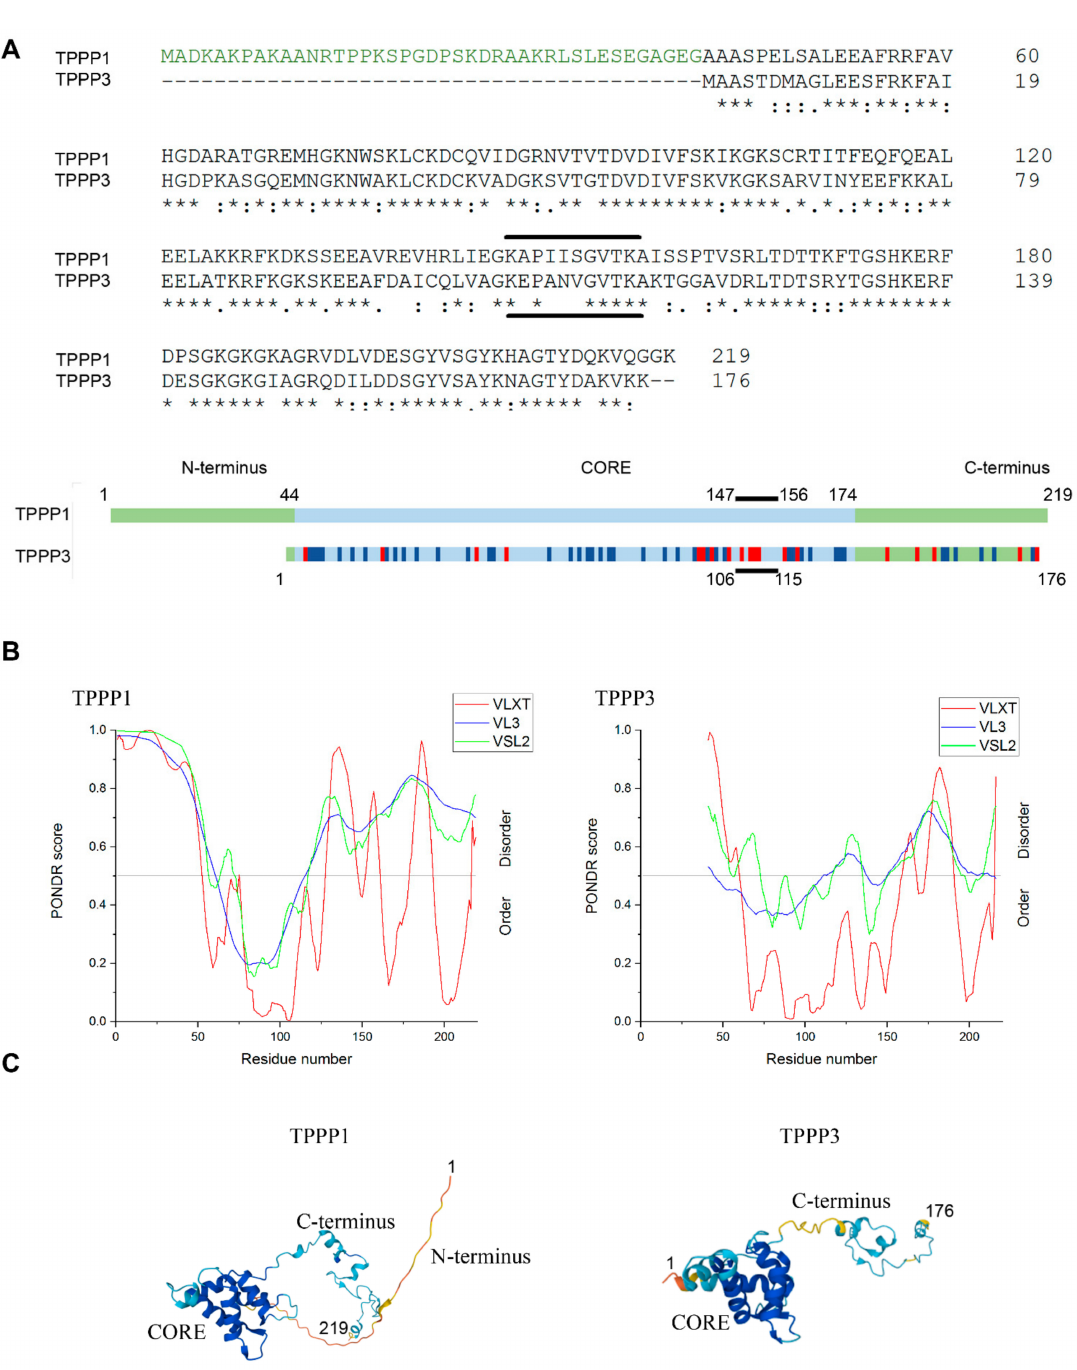
Figure 1. Primary and secondary structures of TPPP1 and TPPP3. ( A ) Multiple alignment of the human TPPP1 and TPPP3 by Clustal Omega (https://www.ebi.ac.uk/Tools/msa/clustalo): identical (*) and similar (: or .) residues. Similar and different residues in the scheme are indicated by dark blue and red, respectively. The TPPP1 segment involved in SYN binding is indicated by lines. ( B ) PONDR prediction of the terminal disorder segments of the proteins evaluated by three algorithms (VLXT, VL3 and VSL2) (http://www.pondr.com). Disorder prediction values (PONDR scores) of a given residue are plotted against the residue number. The residue numbers of TPPP1 are shown for the sake of comparison. Residues considered to be disordered above threshold of 0.5. ( C ) Predicted structures by AlphaFold (https://alphafold.ebi.ac.uk). AlphaFold produces a per-residue confidence score (pLDDT) between 0 and 100 (pLDDT > 90 very high, dark blue; 90 > pLDDT > 70 confident, cyan; 70 > pLDDT > 50 low,